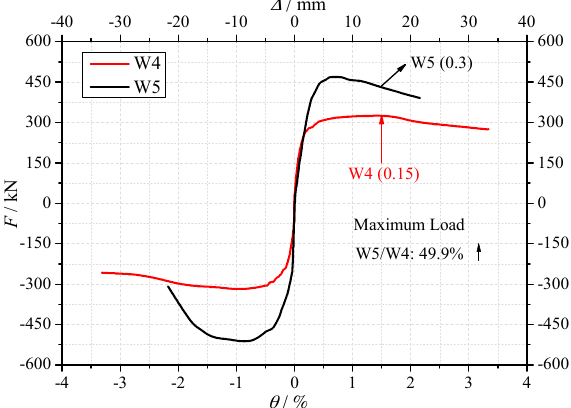
Figure 11. The skeleton curves of the specimens W4 and W5.